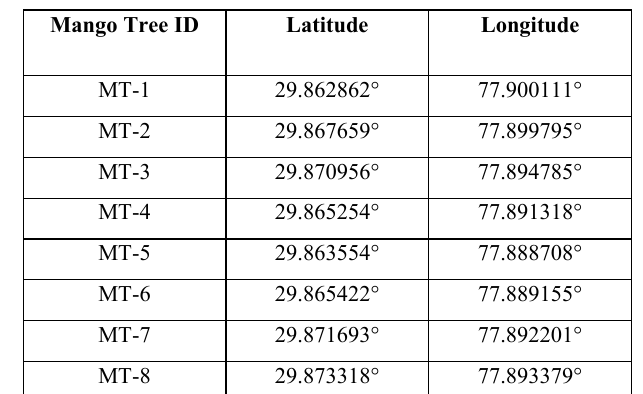
Table 5.Mango Tree ID with Latitude & Longitude Inside the campus